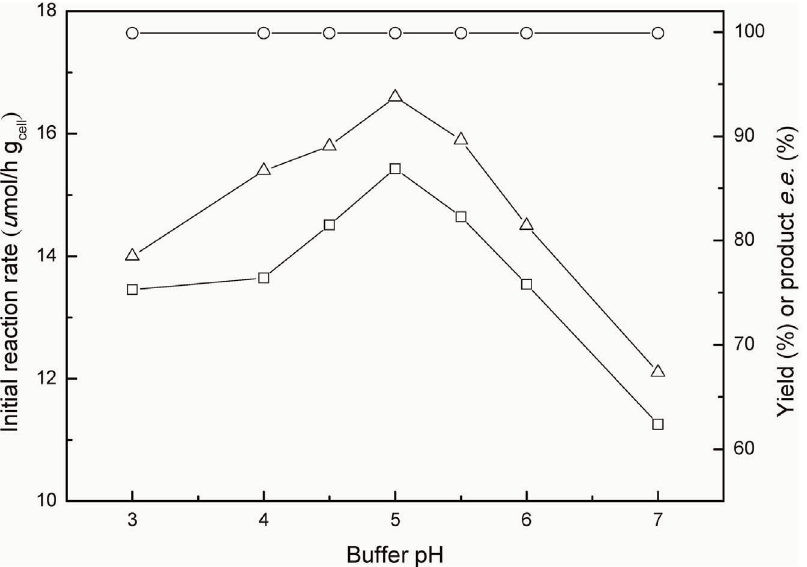
Figure 4. Effect of buffer pH on the bioreduction of TMSB. Symbols: ( g ) the initial reaction rate; ( % ) the maximum product yield; ( # ) the product e.e. All products have the ( S ) configuration. Reaction conditions: 3.0 mmol/L TMSB, 4.0 mL TEA-HCl buffer (100 mmol/L, various pH) containing 10% (v/v) C 2 OHMIM ? NO 3 , 65.3 mmol/L 2-propanol, and 0.15 g/mL immobilized C. parapsilosis cells, 30 u C, 180 r/min.